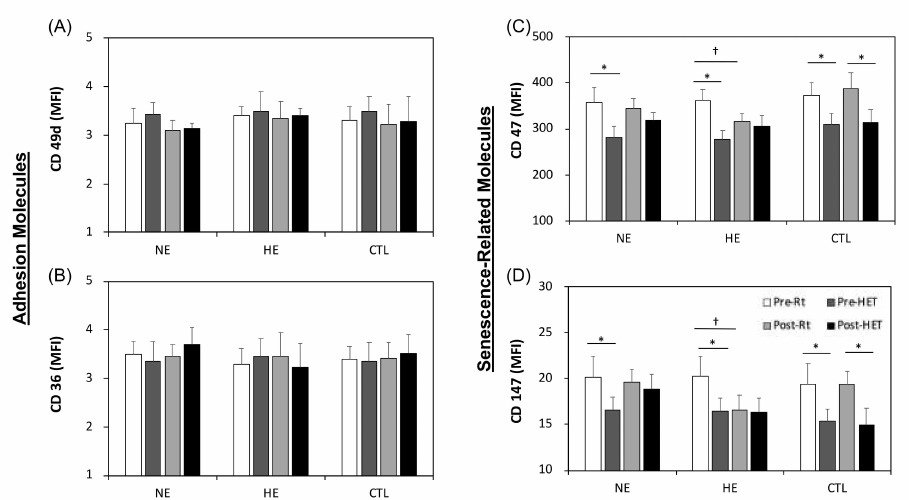
Figure 4. Measurement of adhesion- and senescence-related biomarkers in erythrocytes. The median fluorescence intensities of ( A ) CD49d, ( B ) CD36, ( C ) CD47, and ( D ) CD147. NE, normoxia training group; HE, hypoxia training group; CTL, control group; Pre, pretraining; Post, post-training; Rt, at rest; HET, immediately after HET; MFI, median fluorescence intensity. * p < 0.05, Rt vs. HET; † p < 0.05, pre vs. post. Values are the mean ±